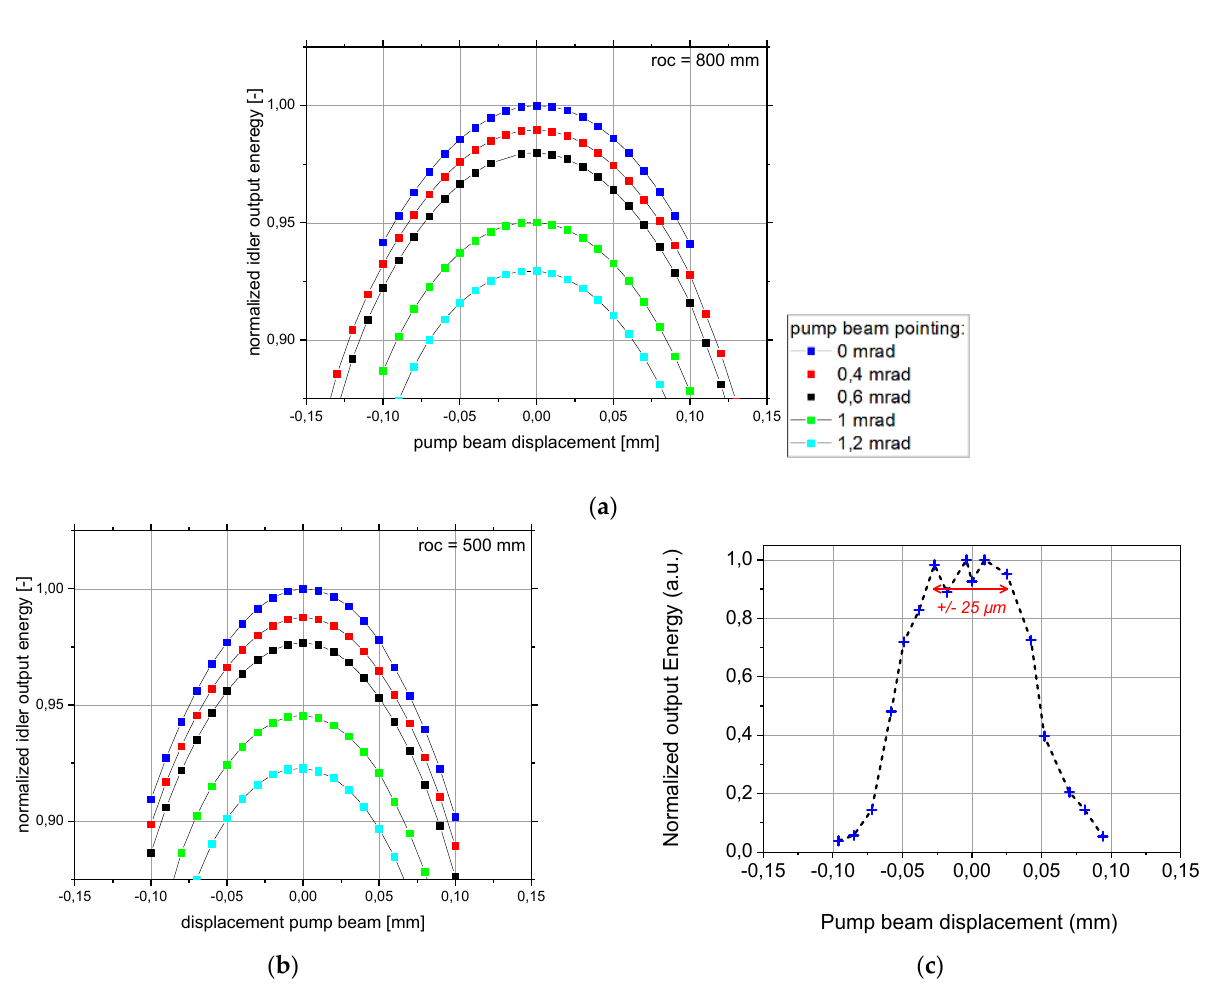
Figure 7. Calculated output idler pulse energy of the NesCOPO in dependency of spatial pump beam displacement. The given angles denote a tilt between the pump beam and the NesCOPO’s optical axis. Results with mirror radii of 800 mm are reported in ( a ). Results with mirror radii of 500 mm are reported in ( b ), experimental results with 500 mm mirror radii are reported in ( c ).